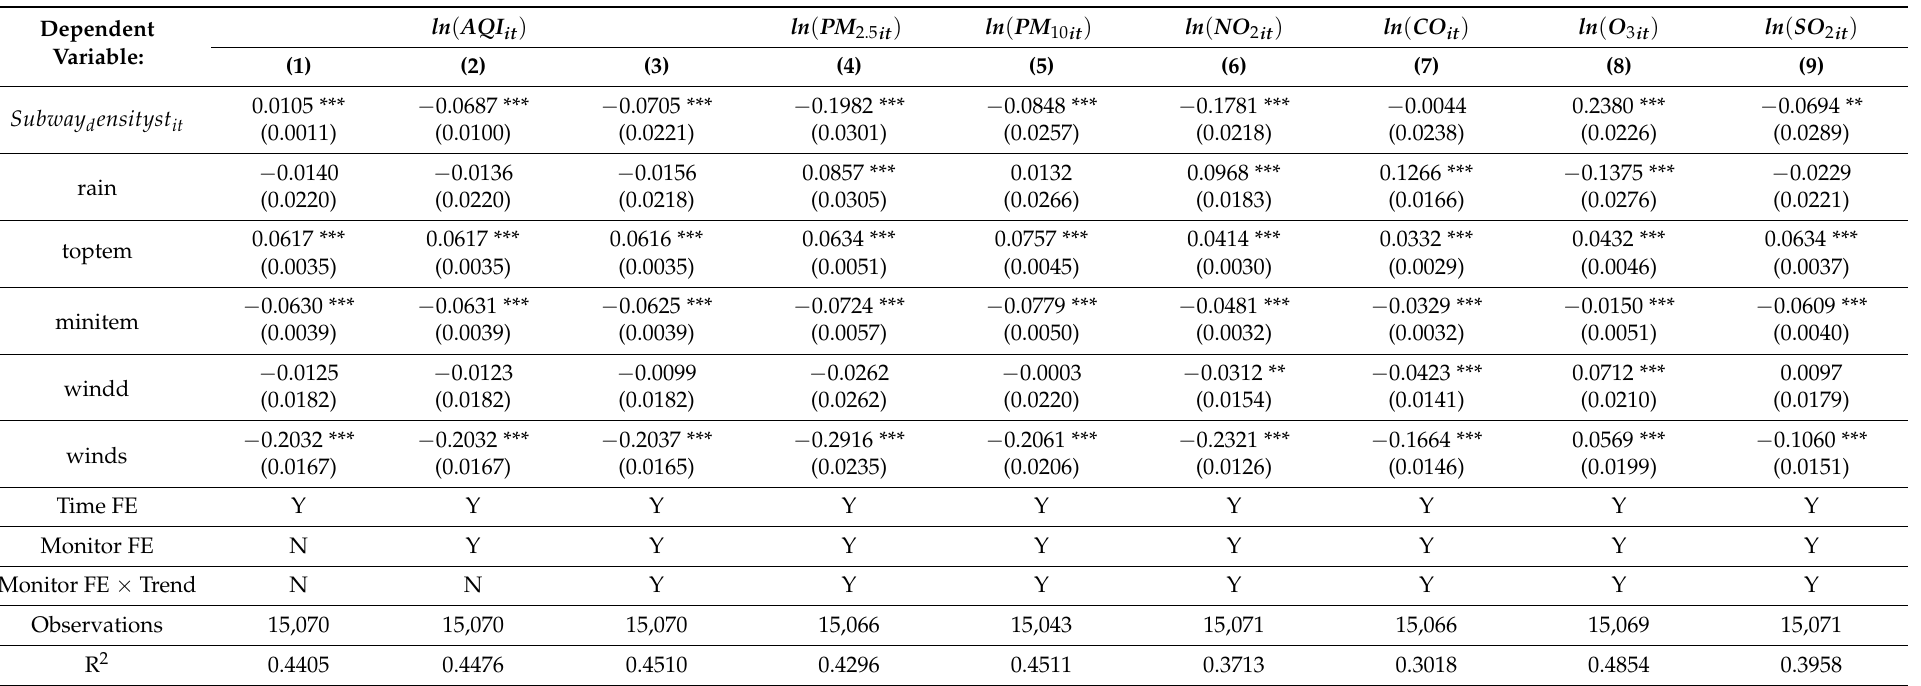
Table 3. The effect of subway network density on air pollutants: Ordinary Least Squares